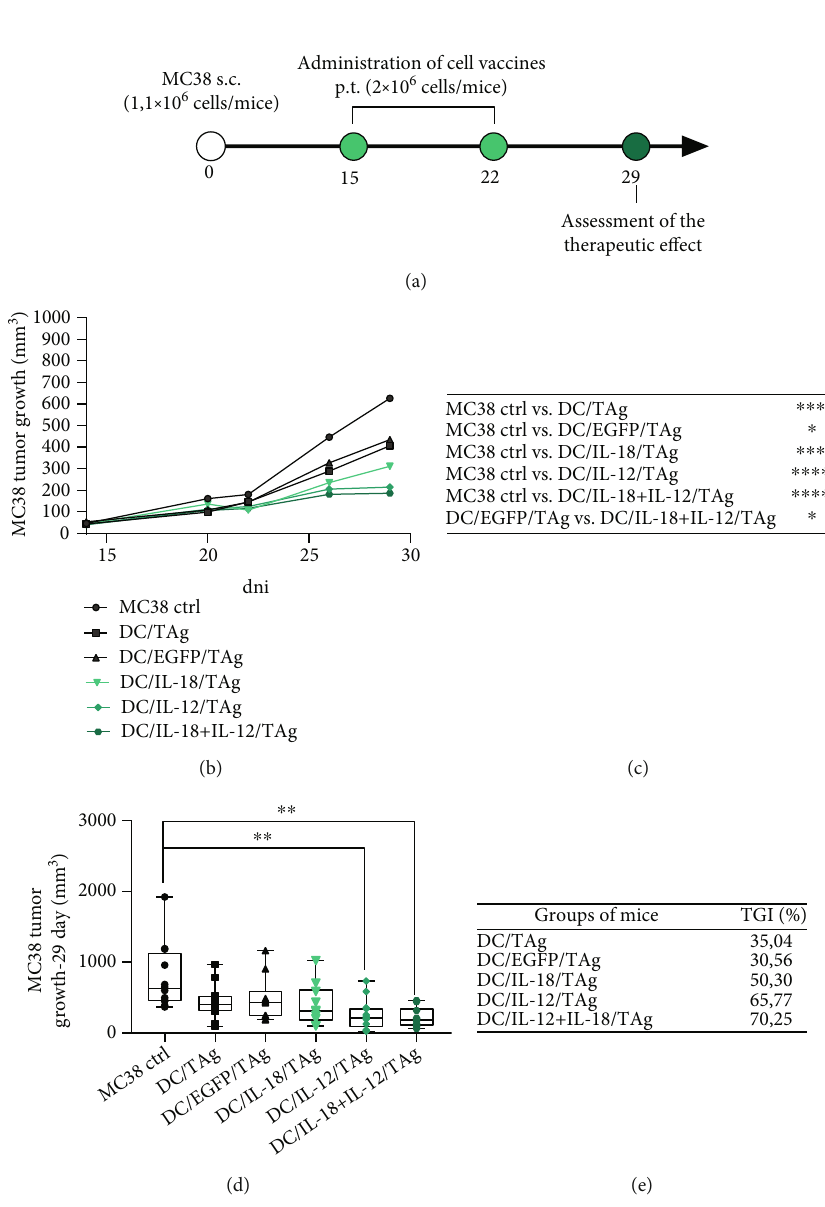
Figure 3: Impact of DC-based vaccines therapy on tumor growth. (a) The C57BL/6 female mice were subcutaneously (s.c.) inoculated in the right fl ank with MC38 colon carcinoma cells ( 1 : 1 × 10 6 cells/mouse, day 0). On the 15th and 22nd days, mice with established tumors were administered peritumorally (p.t.) with DCs genetically modi fi ed for IL-12 and IL-18 coproduction (DC/IL-18/TAg, DC/IL-12/TAg, DC/IL- 18+ IL-12/TAg), stimulated with MC38 tumor cell lysate ( 2 × 10 6 cells/mice) or control cells (DC/TAg, DC/EGFP/TAg). On the 29th day, the therapeutic e ff ect of the administration of vaccines was determined. (b) Graph presenting median tumor volume after immunotherapy. (c) Table presenting statistically signi fi cant di ff erences between groups after immunotherapy. (d) Box graph presenting median tumor volume, calculated on the 29th day of the experiment. (e) Table presenting MC38 tumor growth inhibition (TGI) calculated on 29th day of experiment in relation to the MC38 ctrl group. Results are presented as mean ± SD calculated for 10-13 mice per group. Di ff erences between groups were estimated using the nonparametric Kruskal-Wallis test followed by Dunn ’ s multiple comparison post hoc